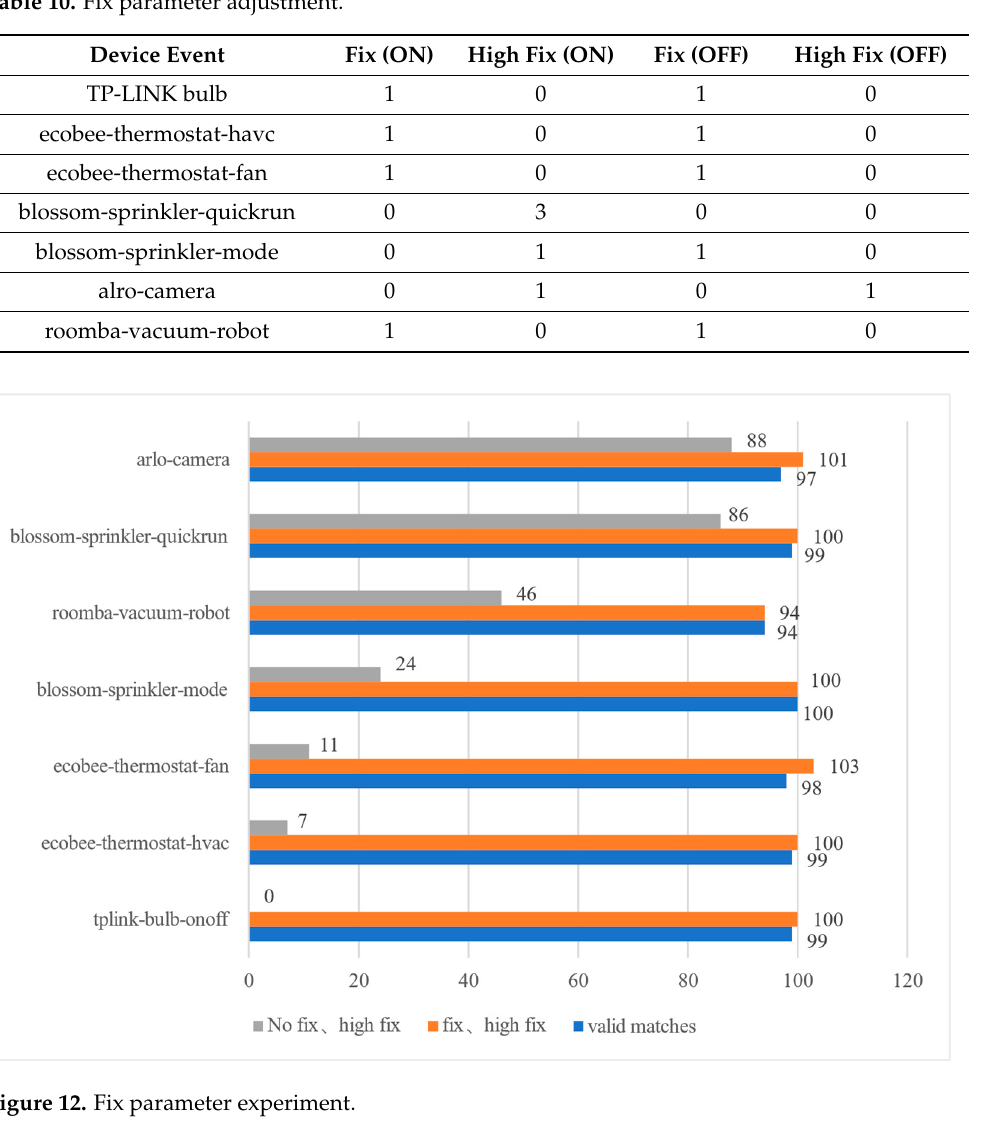
Table 10. Fix parameter adjustment.